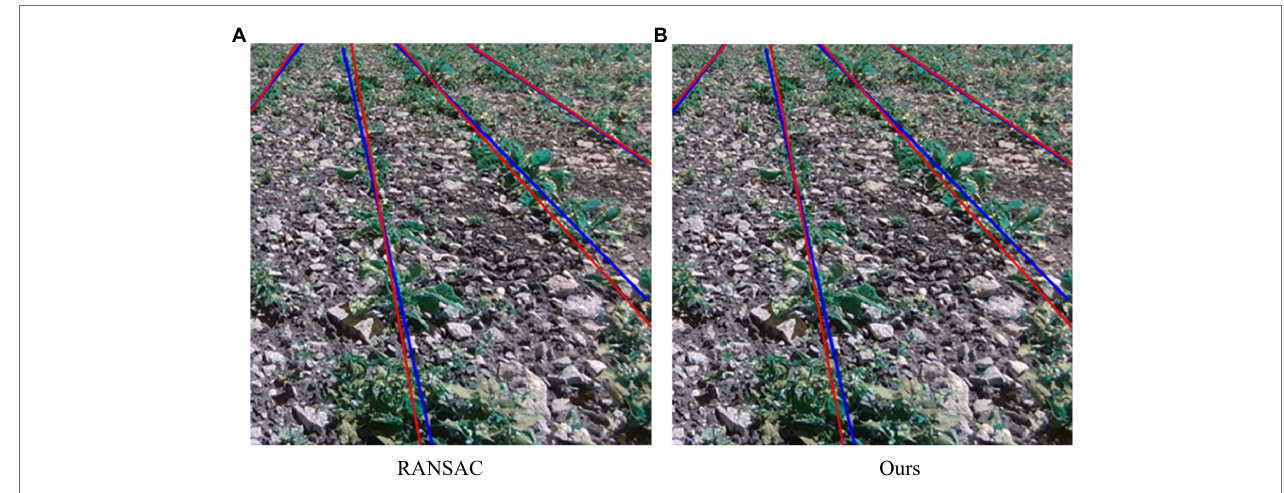
FIGURE 11 | Navigation line fitting results. (A) The red straight line represents the navigation line fitted by the RANSAC algorithm. (B) The red straight line represents the crop row navigation line fitted by our